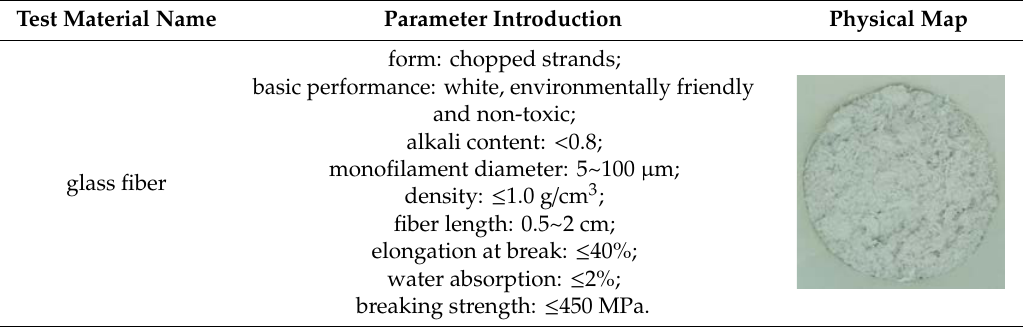
Table 3. Glass fiber basic parameter table.